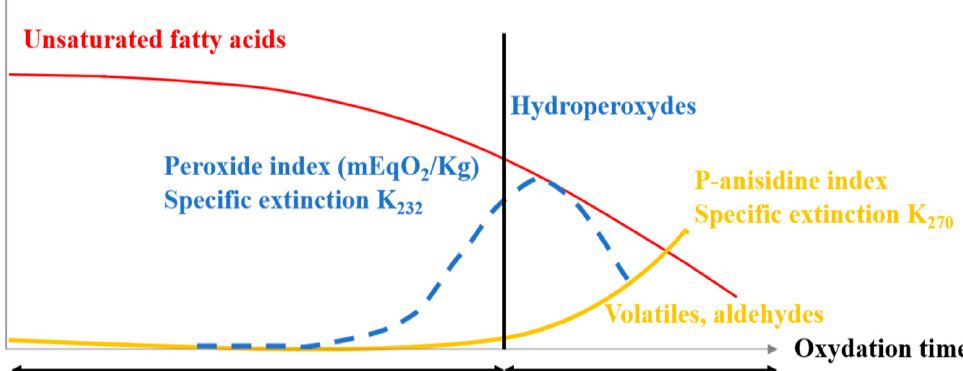
Figure 10. Kinetics of unsaturated fatty acids